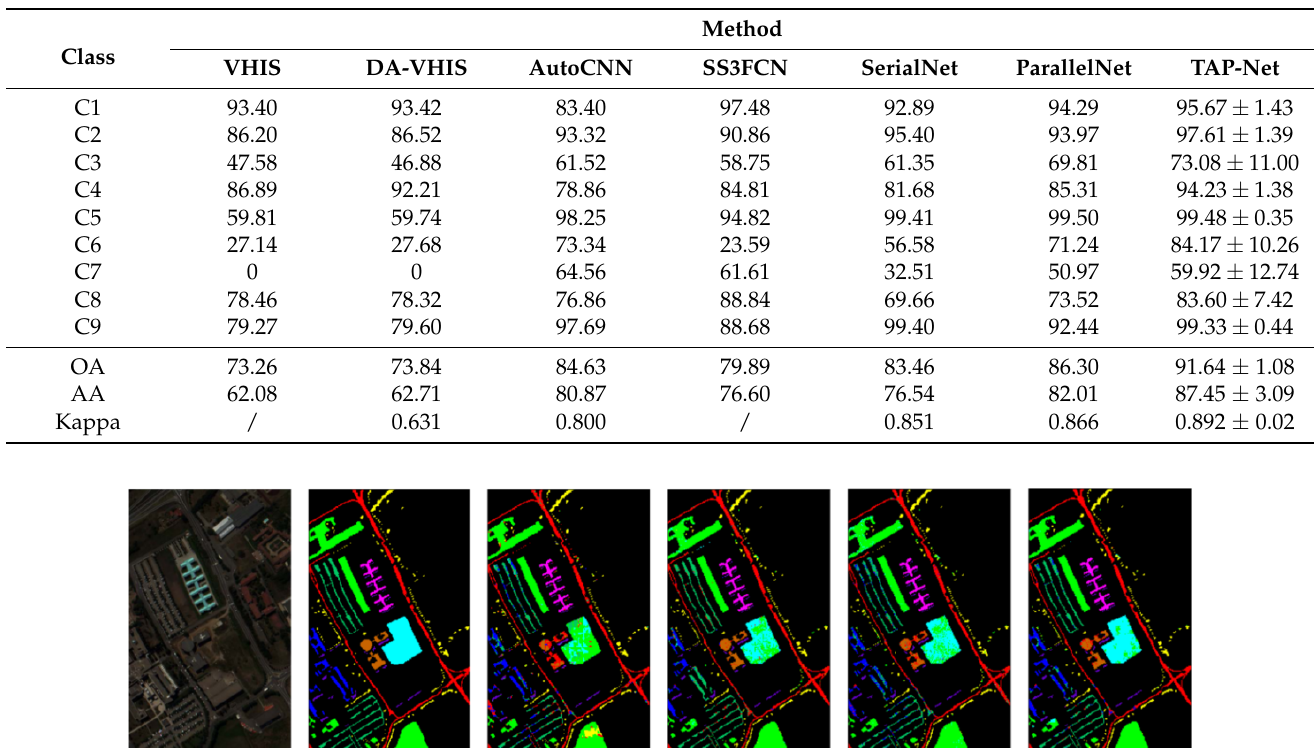
Table 6. Classification results for the Pavia University dataset, including per-class, overall (OA), and average (AA) accuracy (in %), and the Kappa scores.